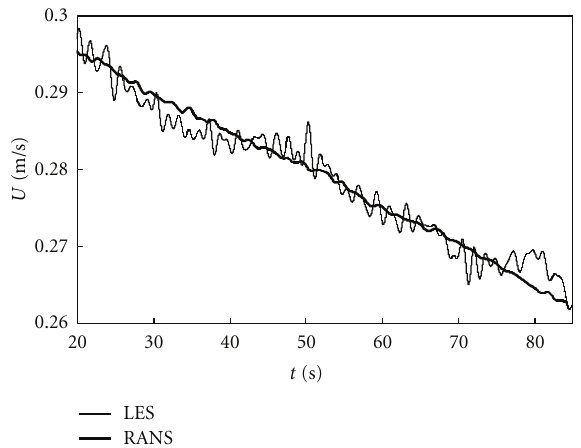
Figure 9: Comparison of temporal fluctuations of velocity at a point by RANS and LES simulations.